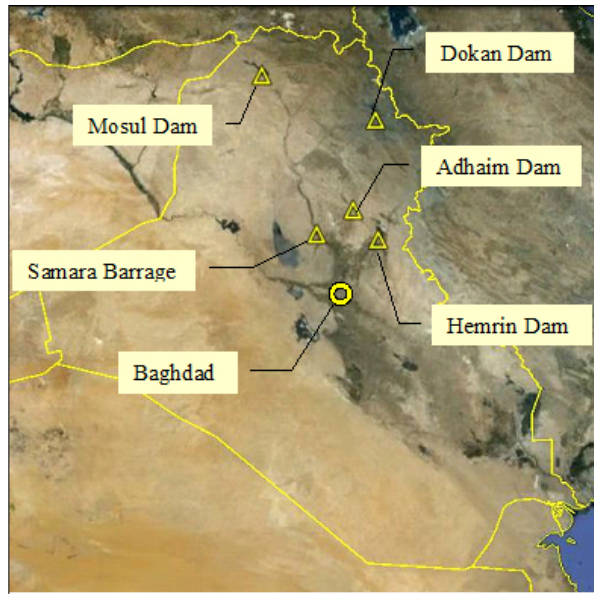
Fig. 3. Location of control structures upstream Baghdad City.